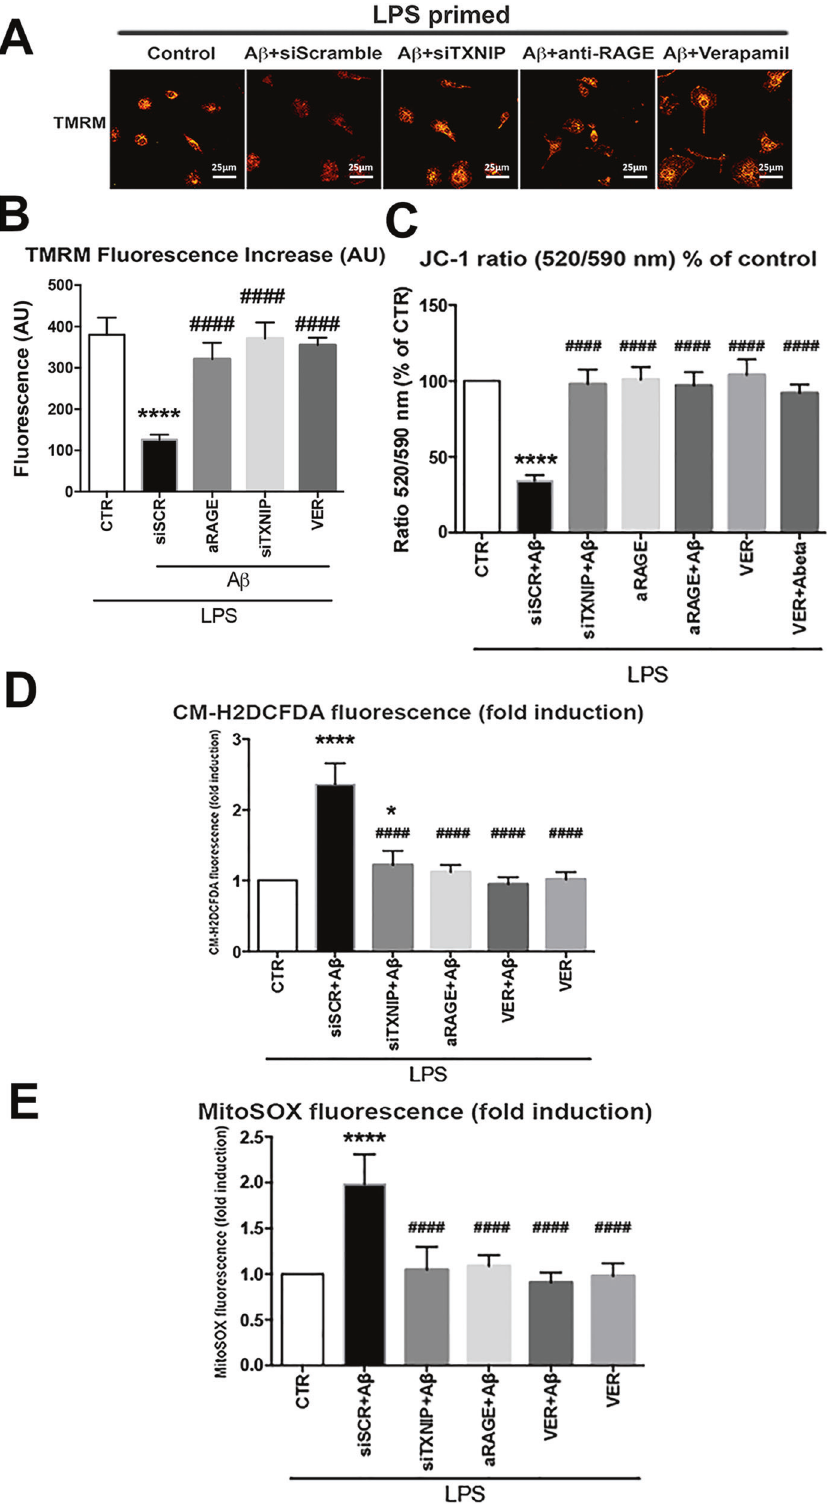
Fig. 4 RAGE – TXNIP axis is implicated in A β -induced changes in mitochondrial membrane potential, ROS formation. A , B IF analysis ( A ) and quanti fi cation ( B ) of TMRM fl uorescence in microglia treated as indicated. One-way ANOVA followed by Tukey ’ s multiple comparison test ( n = 4; **** p < 0.0001 versus control; #### p < 0.0001 versus siScramble). C Quanti fi cation of JC-1 fl uorescence ratio (520/590 nm) in microglia treated as indicated one-way ANOVA followed by Tukey ’ s multiple comparison test ( n = 4; **** p < 0.0001 versus control; #### p < 0.0001 versus siScramble) D Quanti fi cation of CM-H2DCFDA fl uorescence. One-way ANOVA followed by Tukey ’ s multiple comparison test ( n = 12; **** p < 0.0001 versus control; #### p < 0.0001 versus siScramble). E Quanti fi cation of MytoSOX fl uorescence. One-way ANOVA followed by Tukey ’ s multiple comparison test ( n = 6; * p < 0.05, **** p < 0.0001 versus control; #### p < 0.0001 versus